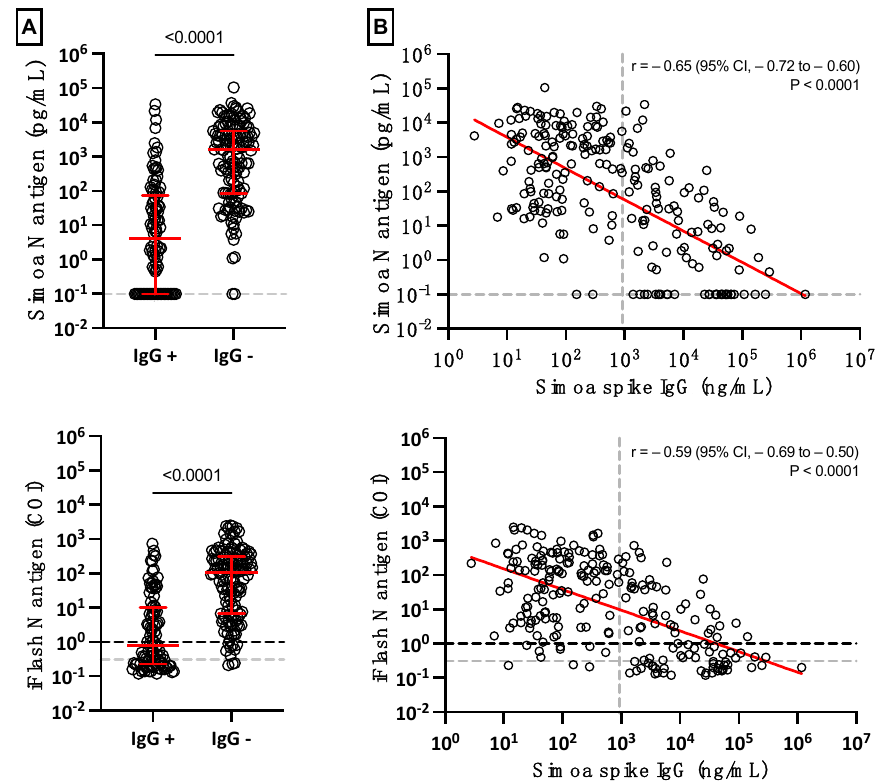
Figure 4. ( A ) Positive and negative SARS-CoV-2 Spike IgG results in serum according to antigenemia. The grey dotted lines on the Y-axis correspond to the positivity cut-off of each antigen assay, as found by ROC curve analyses. The black dotted line on the Y-axis of the iFlash panel represents the cut-off specified by the manufacturer. ( B ) Linear regression of antigenemia obtained with the two antigen assays versus the amount of SARS-CoV-2 Spike IgG. The grey dotted line on the X-axis represents the positivity cut-off for IgG directed against the spike